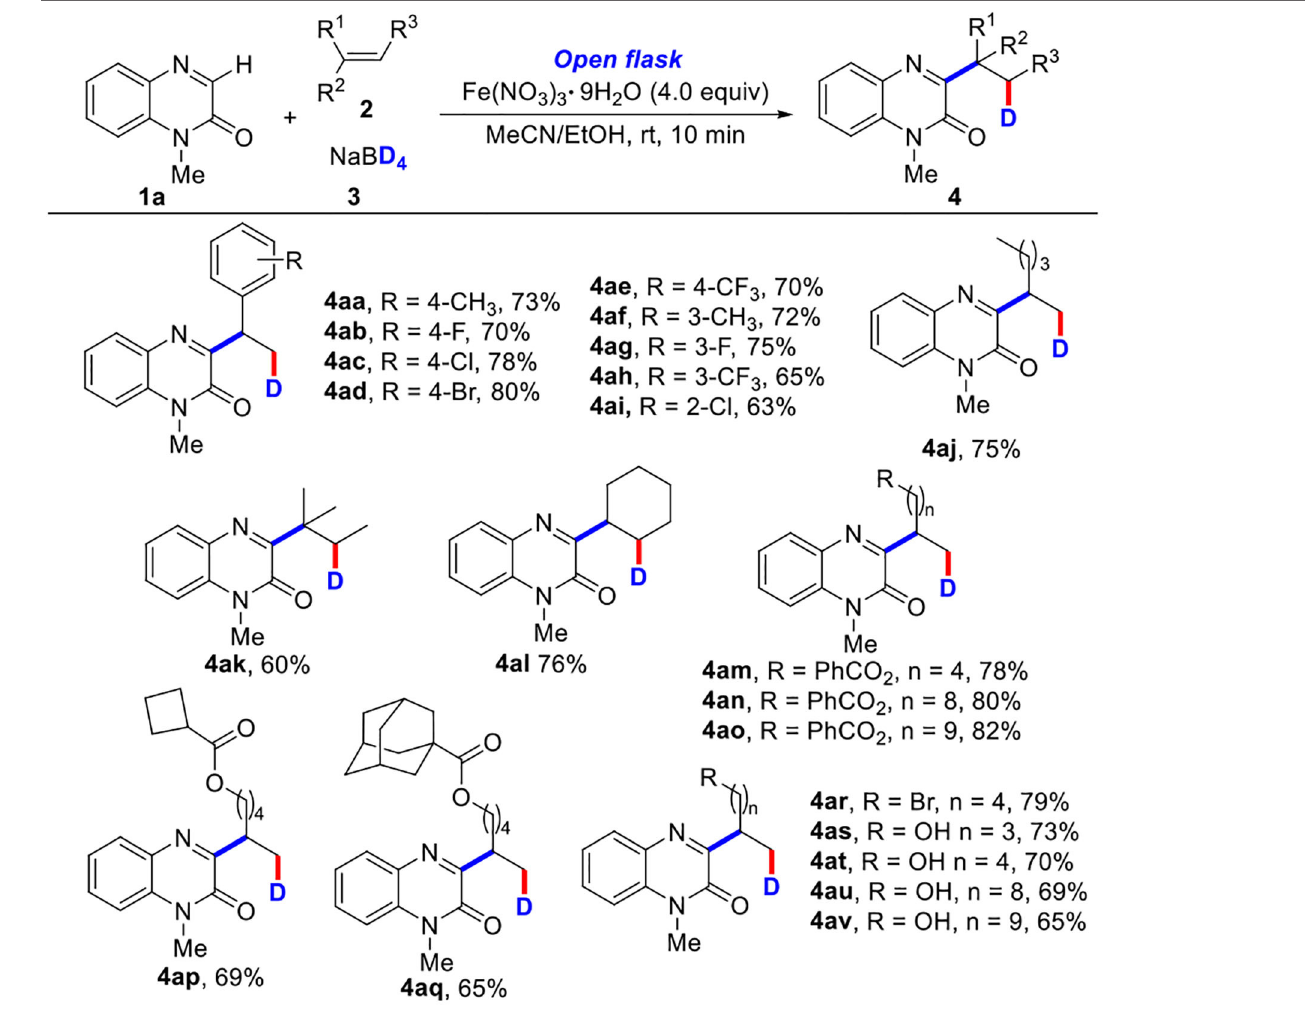
TABLE 3 | Substrate scope of olefins a,b